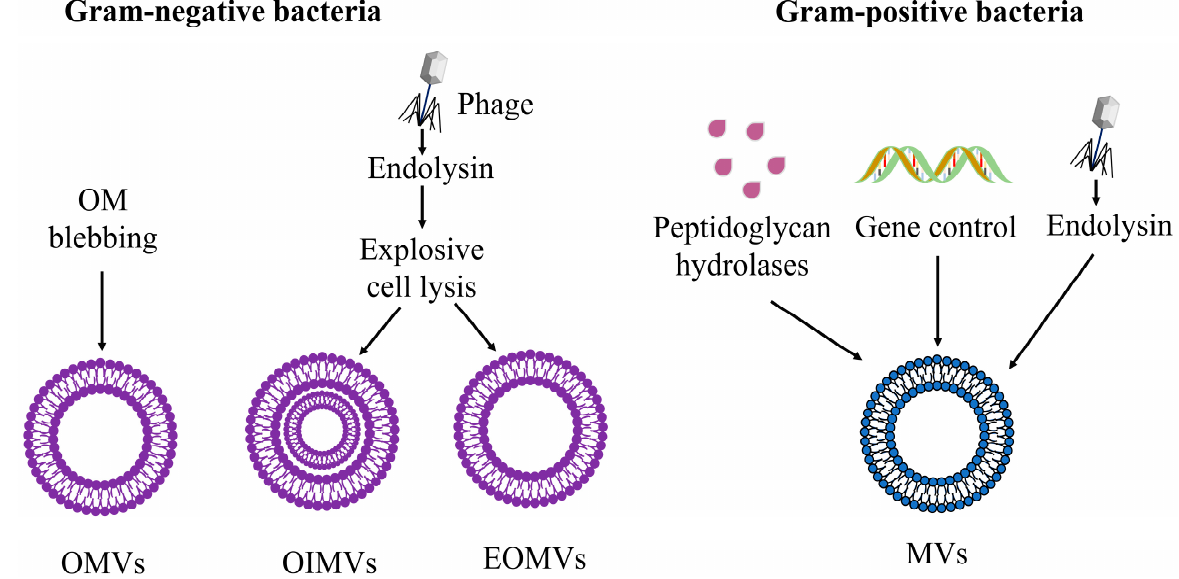
Figure 2. Different pathways for the biogenesis of BMVs.